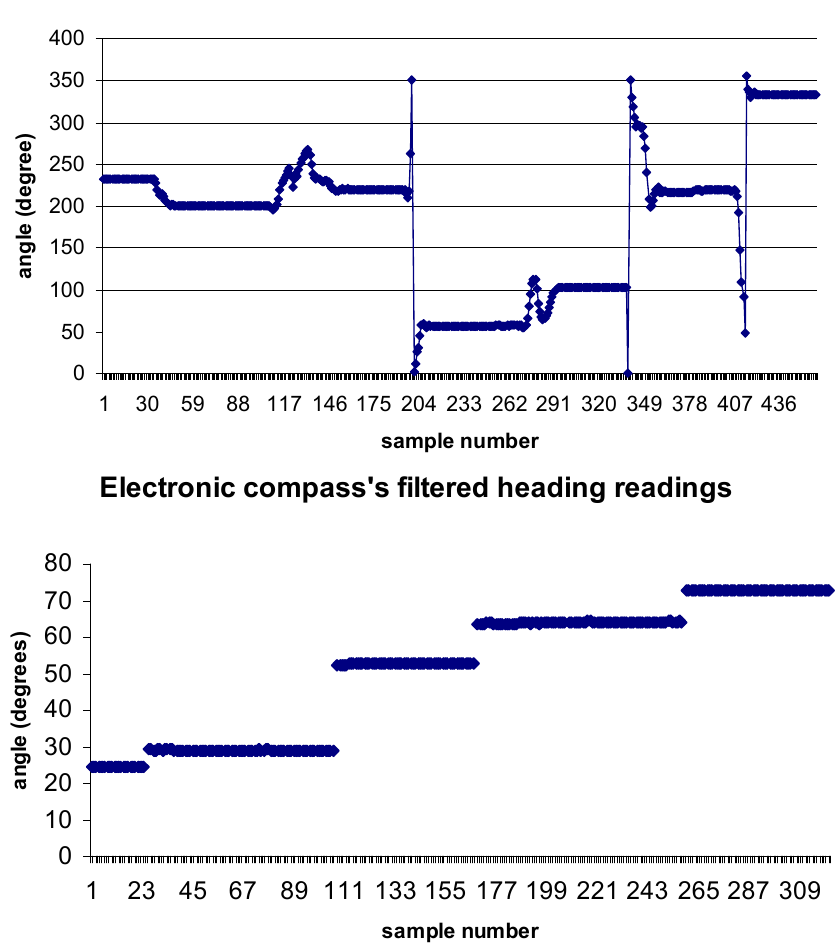
Figure 4. Heading readings obtained with a Honeywell HMR3300 electronic compass: raw readings (perturbations correspond to quick changes of